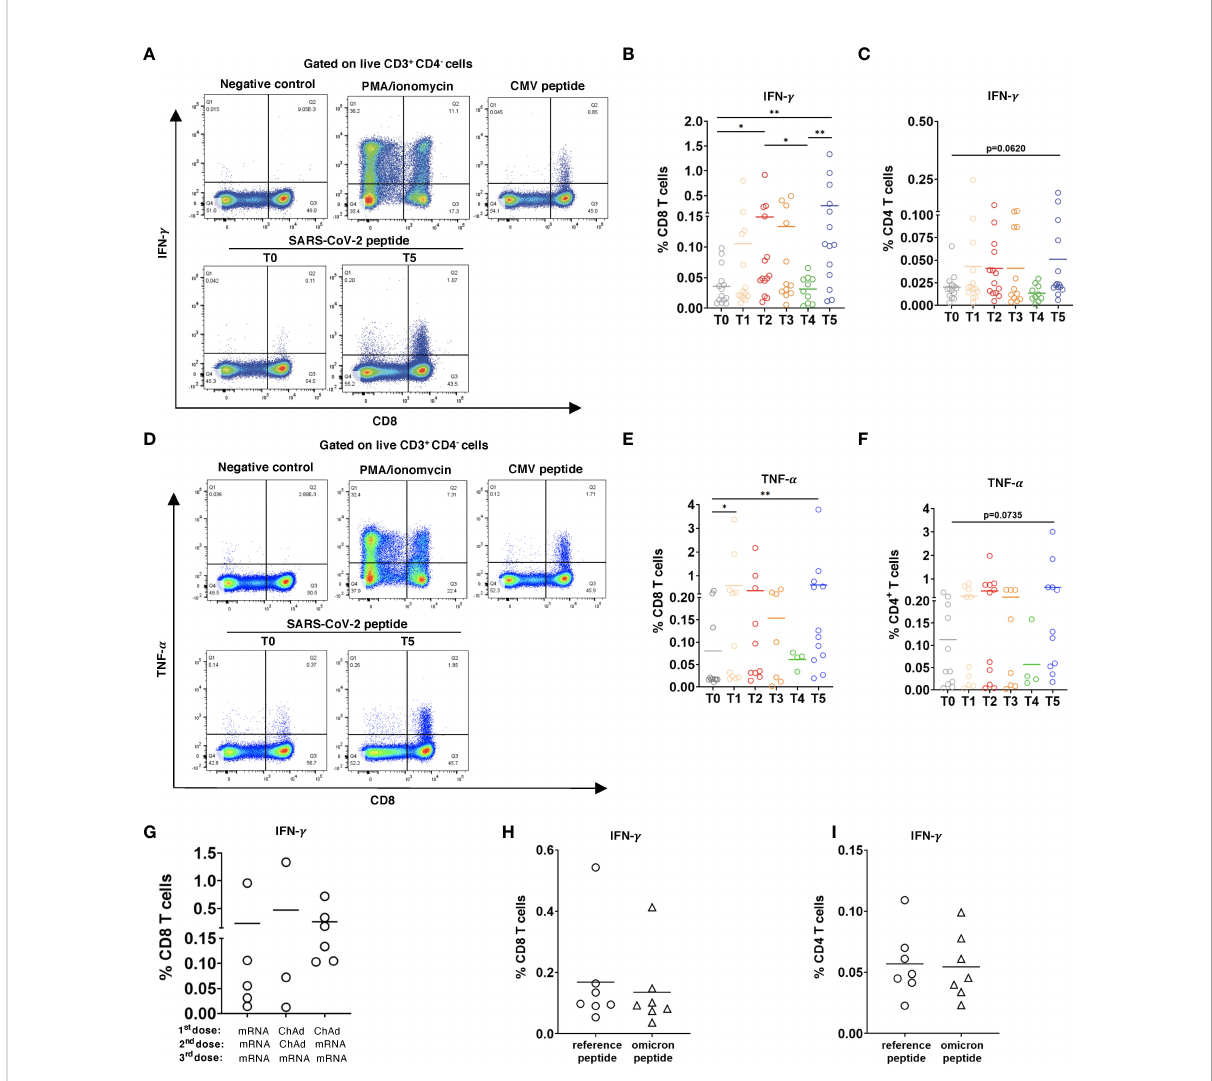
FIGURE 4 CD8 and CD4 T cell responses to SARS-CoV-2 peptides. PBMC (2x10 6 ) were stimulated with SARS-CoV-2 S overlapping peptide pool and anti- CD28 mAb for 6h. The treatment with PMA/ionomycin or CMV peptide pool were used as positive controls, whereas the incubation in medium containing 2% sterile water instead of peptides was considered as negative control. (A) Representative dot plots for IFN- g . production by CD8 T cells at T0 and T5. Negative and positive controls are shown at T5. (B) Data are presented as the percentage of IFN- g + CD8 T cells among total CD8 T cells, (C) as well as IFN- g + CD4 + T cells among total CD4 T cells with the subtraction of positively stained cells in the negative control (n=14). (D) Representative dot plots for TNF- a production by CD8 T cells at T0 and T5. (D-F) Results are shown as the percentage of TNF- a + CD8 + T cells among total CD8 T cells (n= 11, [ (E) ] and TNF- a + CD4 + T cells [n=7, (F) ] among total CD4 T cells. (G) Data on IFN- g producing CD8 T cells in participants vaccinated two times with mRNA (mRNA/mRNA, n=5), two times with ChAd (ChAd/ChAd, n=3) or with ChAd/mRNA (n=6) are presented as the frequency of IFN- g + CD8 + T cells among total CD8 T cells. (H, I) PBMC were stimulated with Omicron peptide pool and reference peptide pool for 6h in the presence of anti-CD28 mAb. Frequency of IFN- g + CD8 + T cells among total CD8 T cells [n=7, (H) ] and IFN- g + CD4 + T cells among total CD4 T cells [n=7, (i) ] are shown. * P < 0.05, ** P <